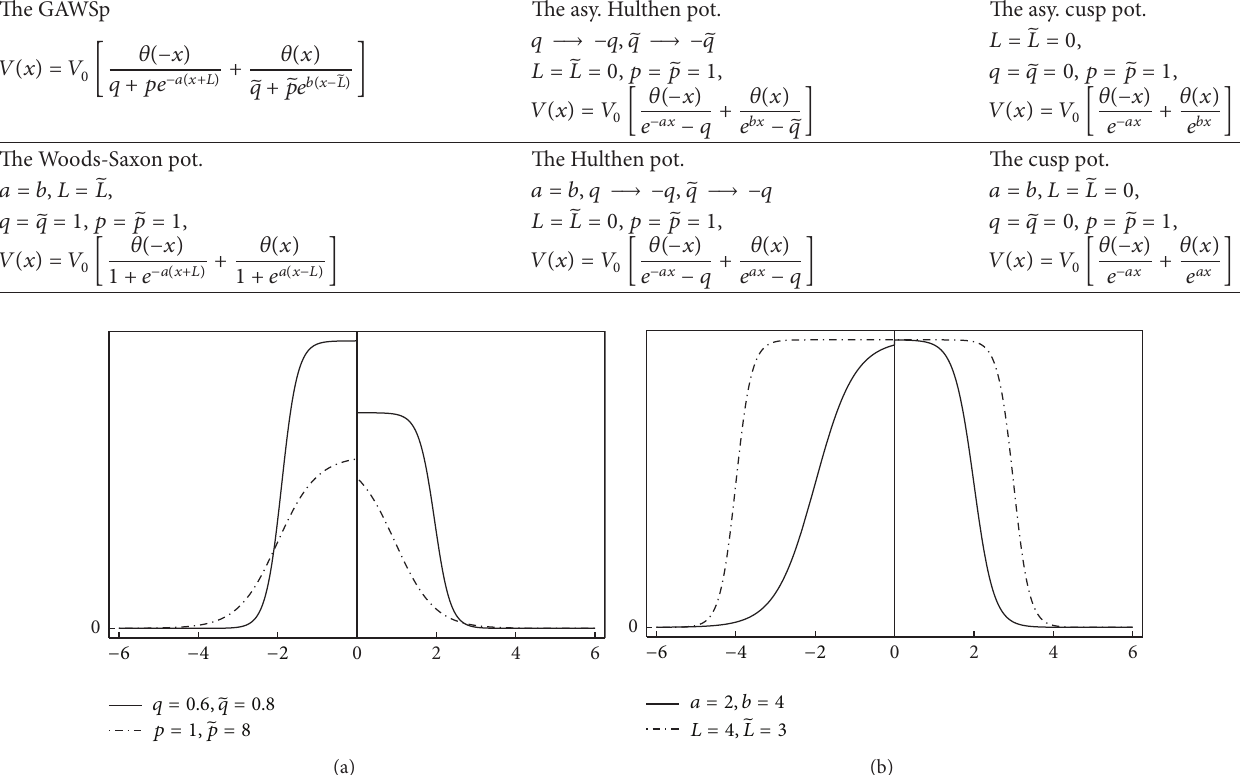
Table 1: The special potentials: the symmetric potentials and asymmetric (asy.) potentials (pot.). The GAWSp The asy. Hulthen pot. The asy. cusp pot.